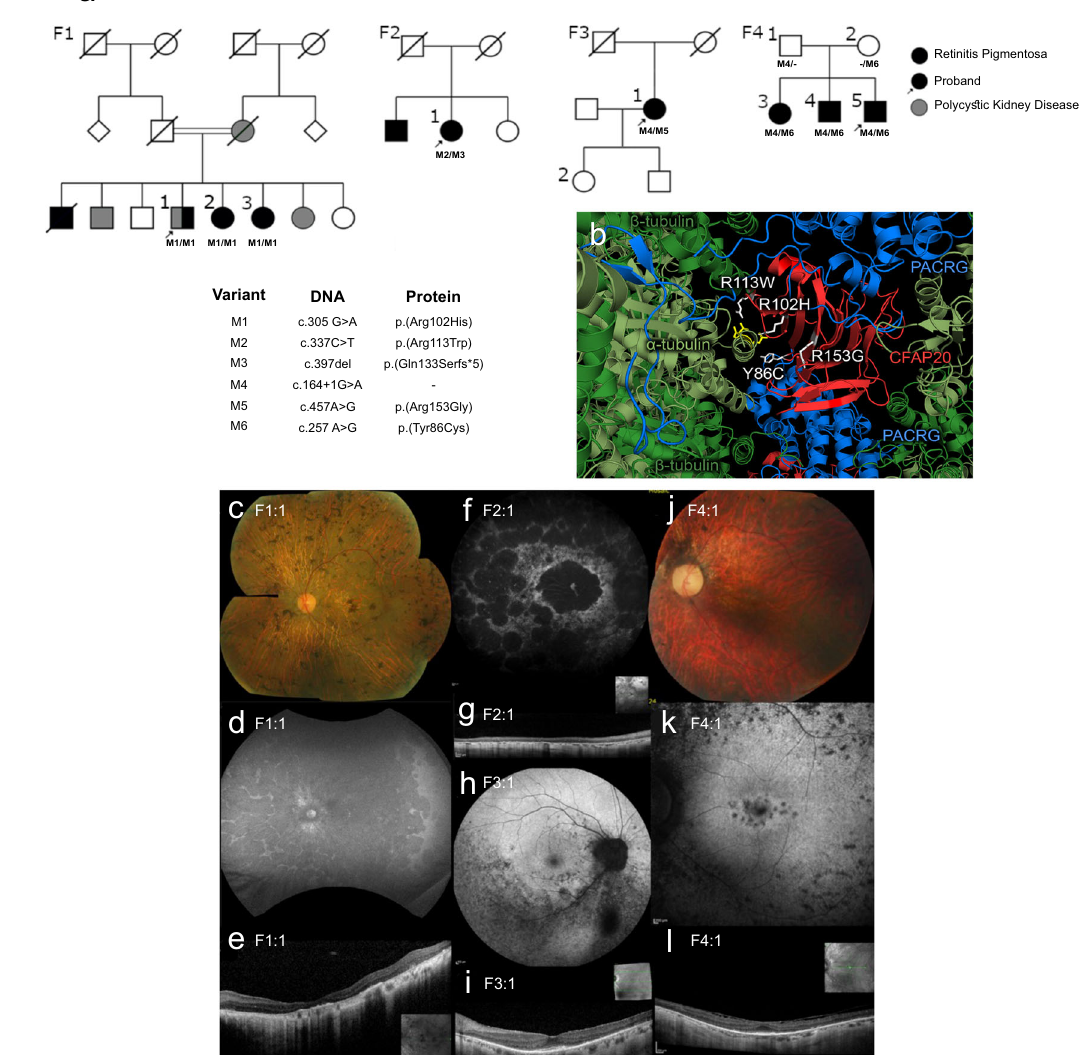
Fig. 5 | CFAP20 variants segregate withautosomal recessive retinaldystrophy. a Four families (F1 through F4) presenting with early-onset, progressive Retinitis Pigmentosa (RP) from two Ophthalmology Centres (UK & Canada). In each pedi- gree, biallelic variants in CFAP20 (M1 thru M6) segregate with RP. Family 1 also exhibits polycystic kidney disease thatsegregates separately from RP and CFAP20 . Arrow indicates proband in each pedigree (Details of symptoms are in Table 1 and summarizedin Supplementary Table3; further detailsof CFAP20 gene variants are in Supplementary Table 2). b The residues altered in each of the four patient variants(white)arepredictedto alterresiduesinthe CFAP20protein(red)thatare on the surface of the protein and therefore may impact upon interactions with PACRG (blue). The variants likely alter key components of the microtubule inner